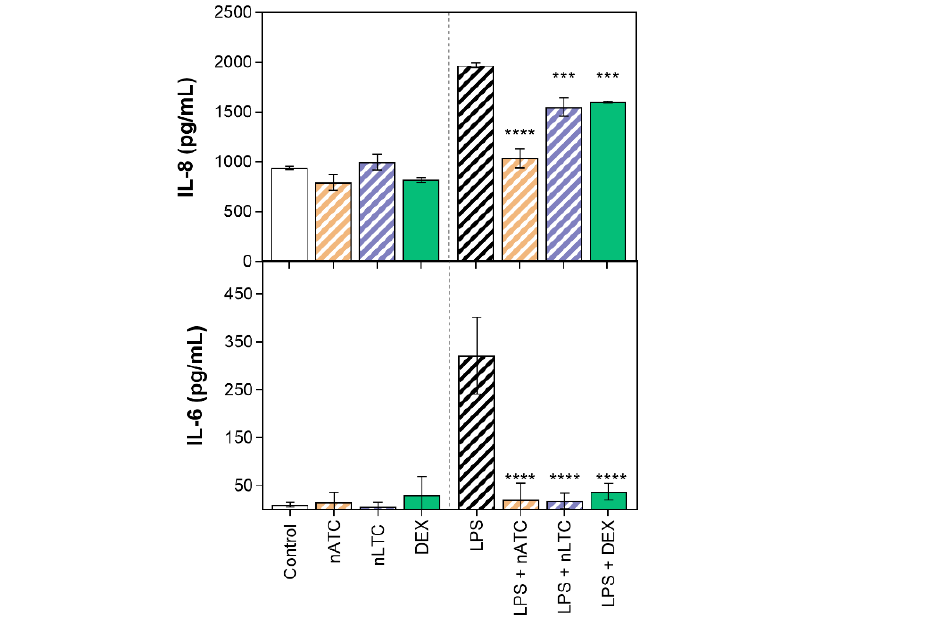
Figure 12. Cellular density after CUR nanovesicles were nebulized on the liquid-air interface of an A549 cells monolayer as an in vitro model of pulmonary alveoli. White arrows point out regions of the monolayers without cells.